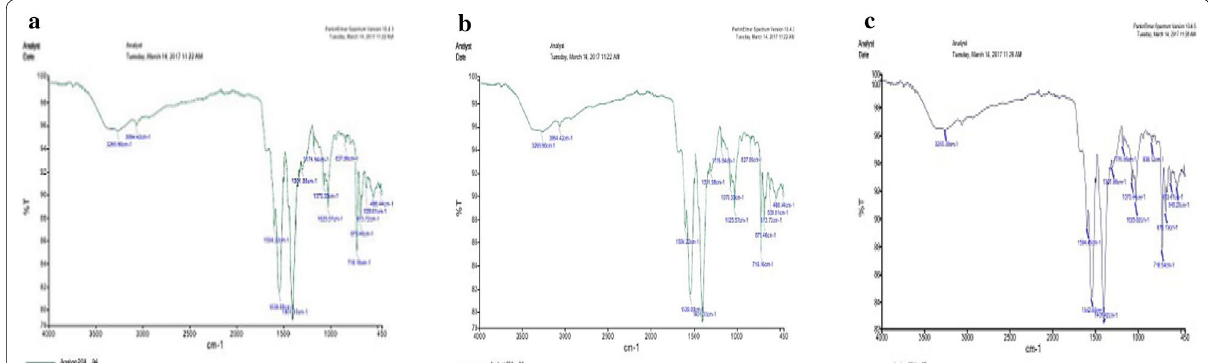
Fig. 3 a FT-IR spectrum of Klebsiella variicola strain AMIC1 without metal loading, b with Ni, c with Co